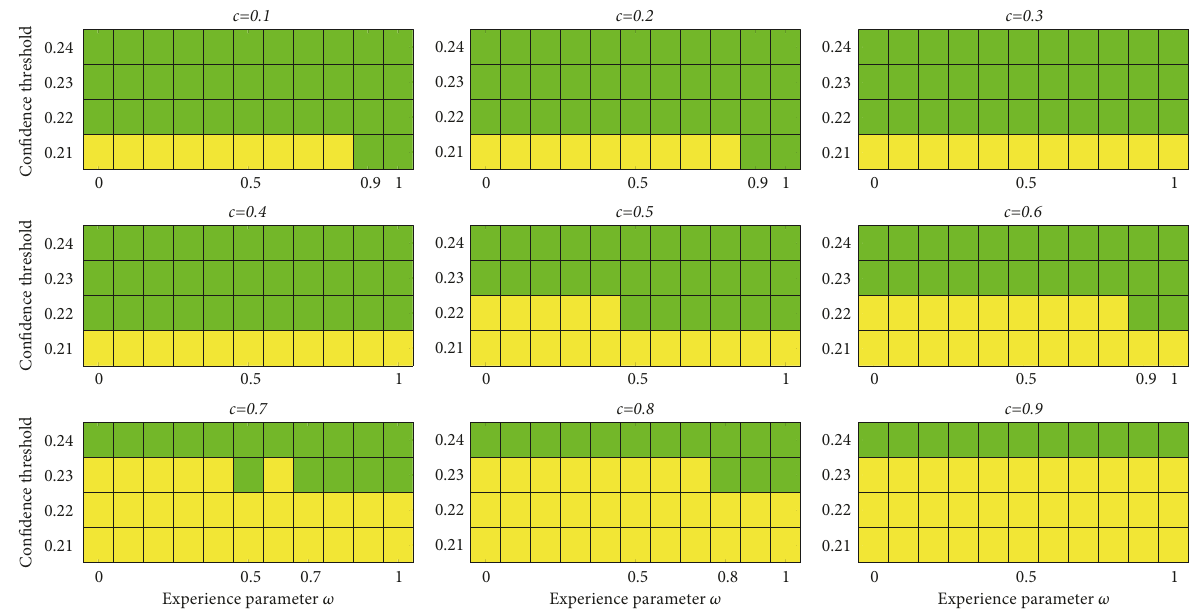
Figure 5: Steady state of the social system with different confidence thresholds, experience parameters ( 𝜔 ), and cognitive parameters ( 𝑐 ).